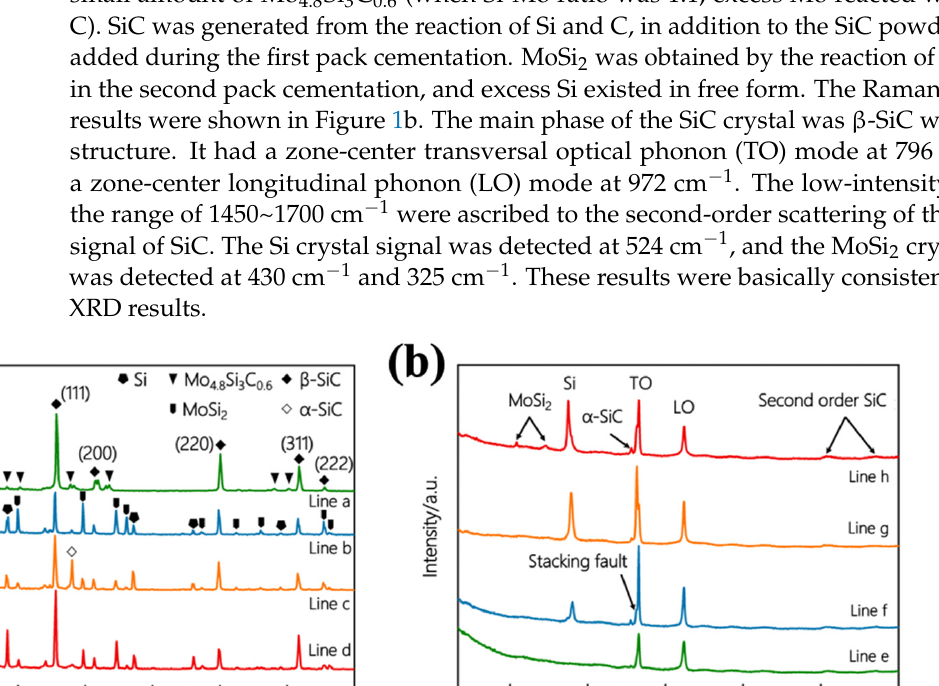
Figure 2. SEM images of the surface of SiC/MoSi 2 -SiC-Si coatings with different Si/Mo ratio: ( a ) 1:1, ( b ) 3:1, ( c ) 5:1, ( d ) 7:1. The microstructure of the coatings’ cross-section was shown in Figure 3. The thick- ness of the coatings with different compositions was similar, and the overall thickness was about 1mm. There was good adhesion between the inner coating and the graphite sub- strate, and also between the outer coating and the inner coating, with no obvious bound- ary. According to the results of EDS, the white part in the image was dominated by MoSi 2 and free Si phase, while the dark part was SiC and free Si phase. The four coatings all had a relatively uniform dark layer on the inner side closest to the graphite substrate, repre- senting the inner SiC coating produced by the first pack cementation. However, as the Si- Mo ratio increased, the thickness of the loose part of the outermost layer gradually de- creased, and the structure of the external coating introduced by the second pack cemen- tation was quite different. During the second embedding, Si, Mo, and C powder reacted under vacuum at 2173 K to generate MoSi 2 and SiC. When the Si-Mo ratio was 1:1, the molar ratio of Si-C-Mo was 3.4:2.4:1. At this time, the amount of Si was not enough to fully react with C and Mo, thus the external coating had only a small amount of unreacted free silicon, leaving many voids as a whole, as shown in Figure 3a. When the Si-Mo ratio was increased to 3:1, the molar ratio of Si-C-Mo was 10.3:4.9:1. The overall content of unreacted Si in the outer coating was still relatively small, so although it was much denser than Si- Mo 1:1, still distributed with many tiny holes. When the Si-Mo ratio was further increased